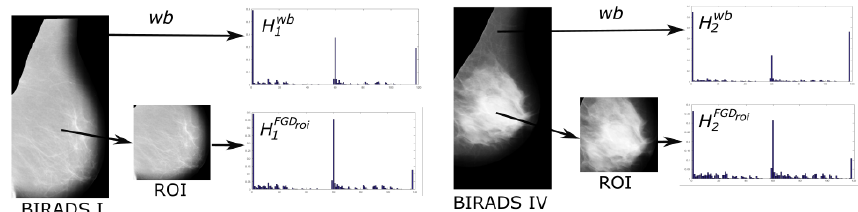
Figure 13. Histograms extracted from the wb versus region of interest (ROI) with BIRADS class I and